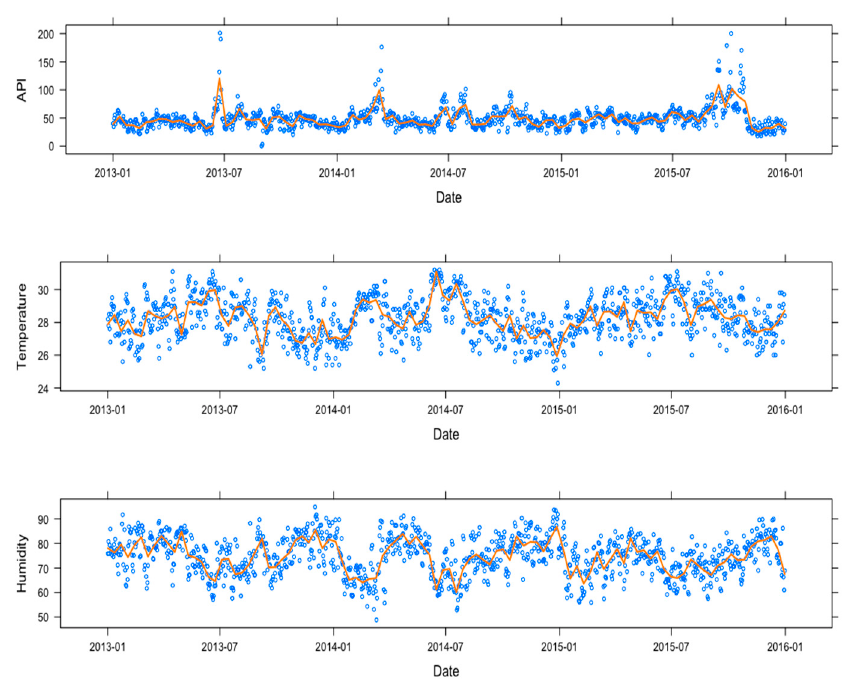
Figure 2. Seasonal pattern of temperature, relative humidity, and air pollution levels in Petaling Jaya (PJ), 2013–2015.